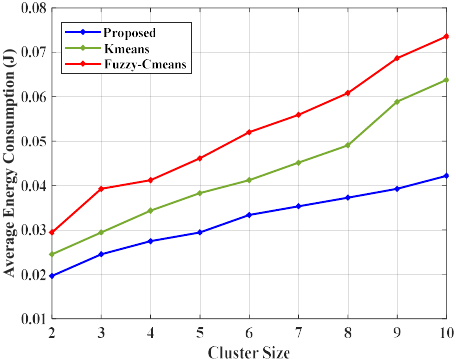
Figure 3. Performance analysis of the energy consumption of the proposed ASFO algorithm. Table 2. Comparison of the average energy consumption of the proposed ASFO algorithm. Approaches